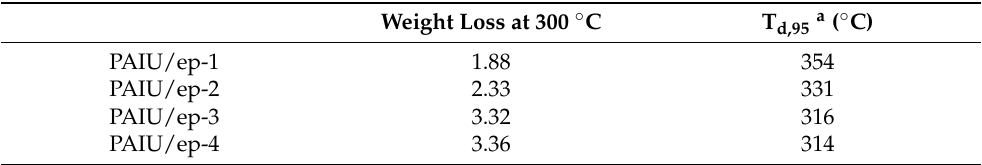
Table 3. TGA weight loss behavior of PAIU/epoxy IPN.